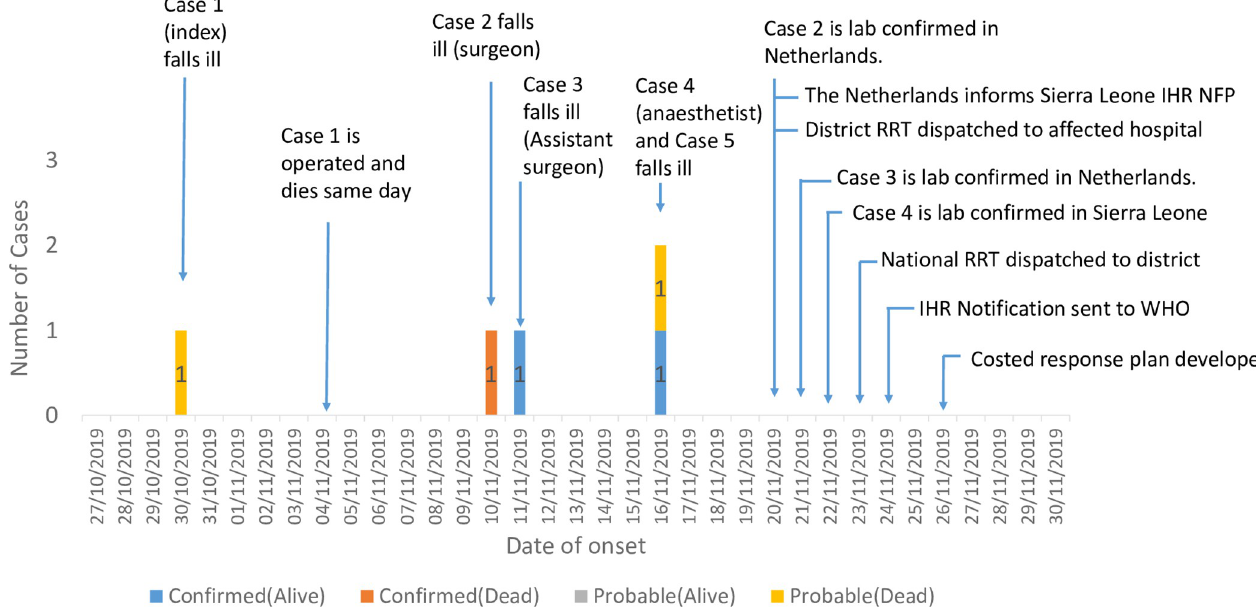
Fig 1. Sequence of events for the Lassa fever outbreak, Tonkolili District, Sierra Leone, 2019. IHR NFP-International Health Regulations National Focal Point; RRT- Rapid Response Team.